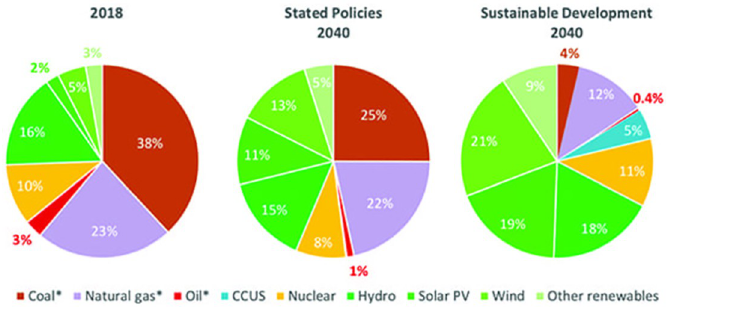
Fig 1. Global primary energy consumption by energy source (2010–2050) [8].